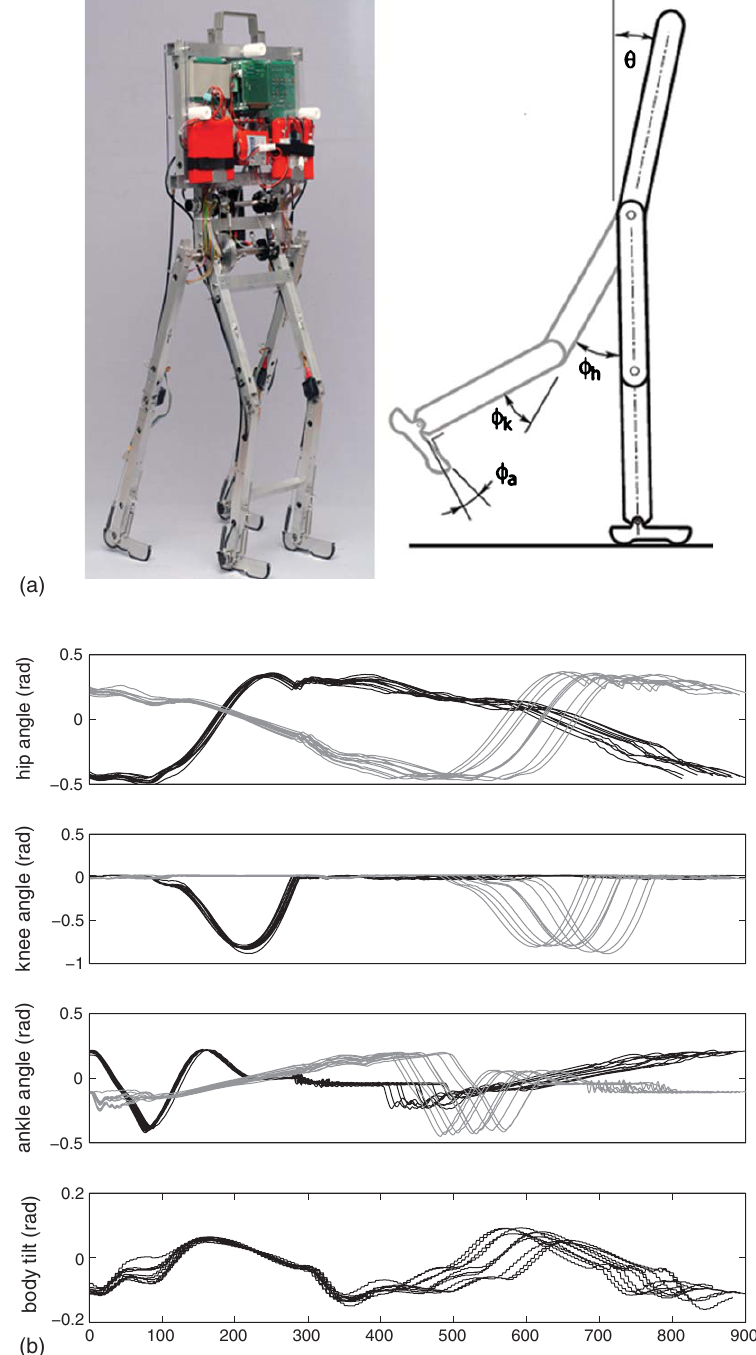
Fig. 4. Limit Cycle Walker Meta: Appearance, schematic representation, and joint angles during normal walking. (a) Appearance and schematic representation depicting the DoF of Meta. Because of the coupling between the inner and outer pairs of legs the walker may be thought of as two dimensional. (b) Joint angles (rad) for the hip, knee, ankle, and body tilt of 10 (out of 28) strides employed to calculate the RLC of Meta. Data sampled at 500Hz. The black and grey lines represent the inner and outer legs